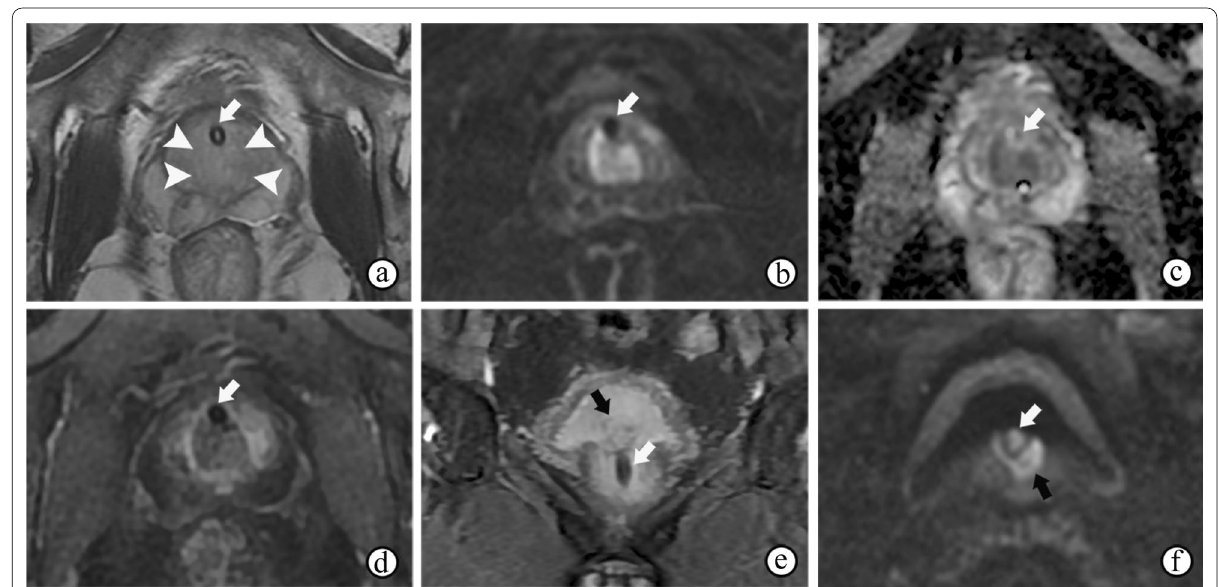
Fig. 15 Malignant solitary fibrous tumor originating from the prostatic urethra in a 62-year-old male with a slightly elevated serum PSA level (4.770 ng/mL) and a Foley catheter to relieve urinary retention (white arrow). a T2WI shows a heterogeneously hyperintense nodule (1.8 cm in size) with an obscured hypointense capsule (arrowhead) behind and adjacent to the prostatic urethra in the prostate. b, c DWI at a b-value of 1400 s/ mm 2 and ADC maps show that the nodule exhibits mildly and inhomogeneously restricted diffusion. d DCE imaging shows continuously mild and heterogeneous enhancement of the nodule. e, f Coronal fat-suppressed T2WI and DWI at a b-value of 1400 s/mm 2 show the nodule protruding into the bladder (black